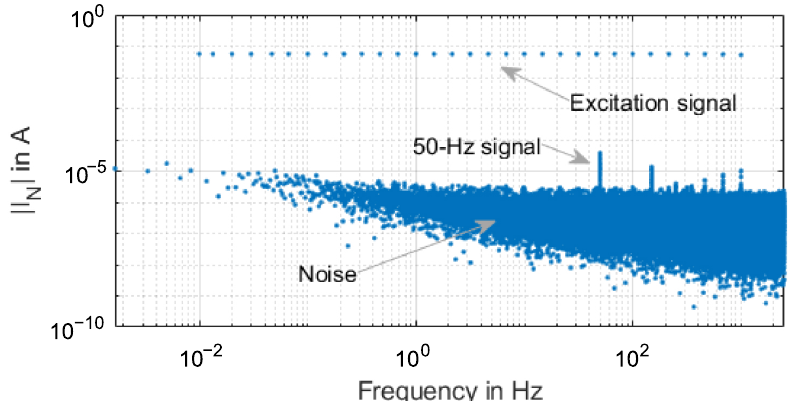
Figure 12. Frequency spectrum of the measured excitation multisine